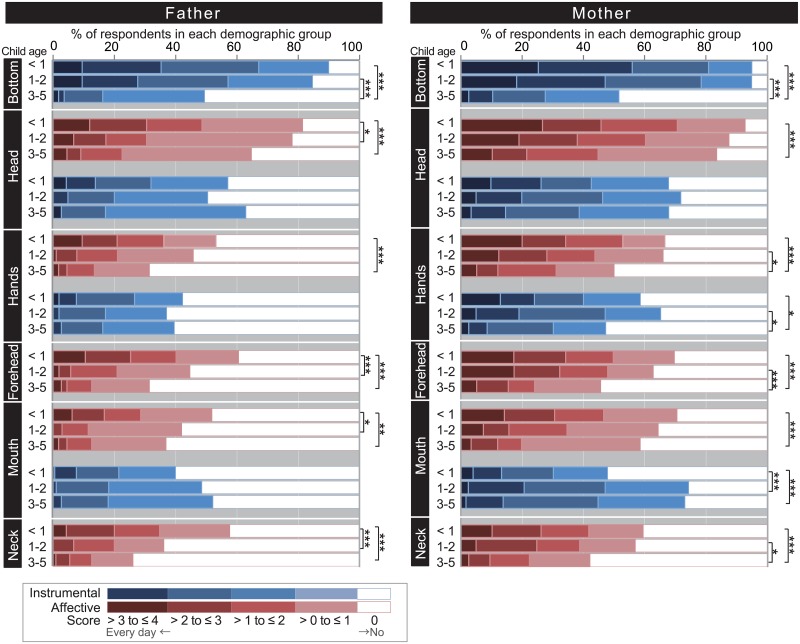
Cumulative bar chart showing differences in scores for the Child Odor in Parenting (COPs) subscales across child age groups.Scores on the COPs subscales are summarized for six demographic groups (i.e., parents’ sex and child age groups; total n = 888). Scores for subscales comprised of the Instrumental factor are shown in blue, and for the Affective factor in pink. Scores for subscales were calculated by averaging 5-point rating scores across items (0, no expreience; 4, everyday, see Table 1 for detail). The Kruskal–Wallis test followed by a pair-wise Mann-Whitney test with Bonferroni correction was used to examine differences among child-age groups within each sex (father/mother). *p < .05. **p < .01. ***p < .001. Comparisons between sex and body parts are shown in S1 and S2 Figs.